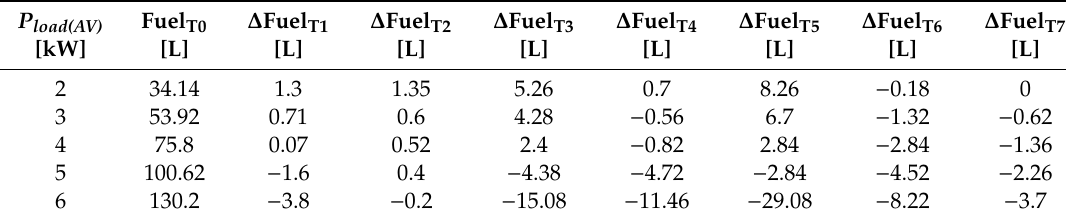
Table 5. Fuel economy for k fuel = 0 and di ff erent P load(AV) .